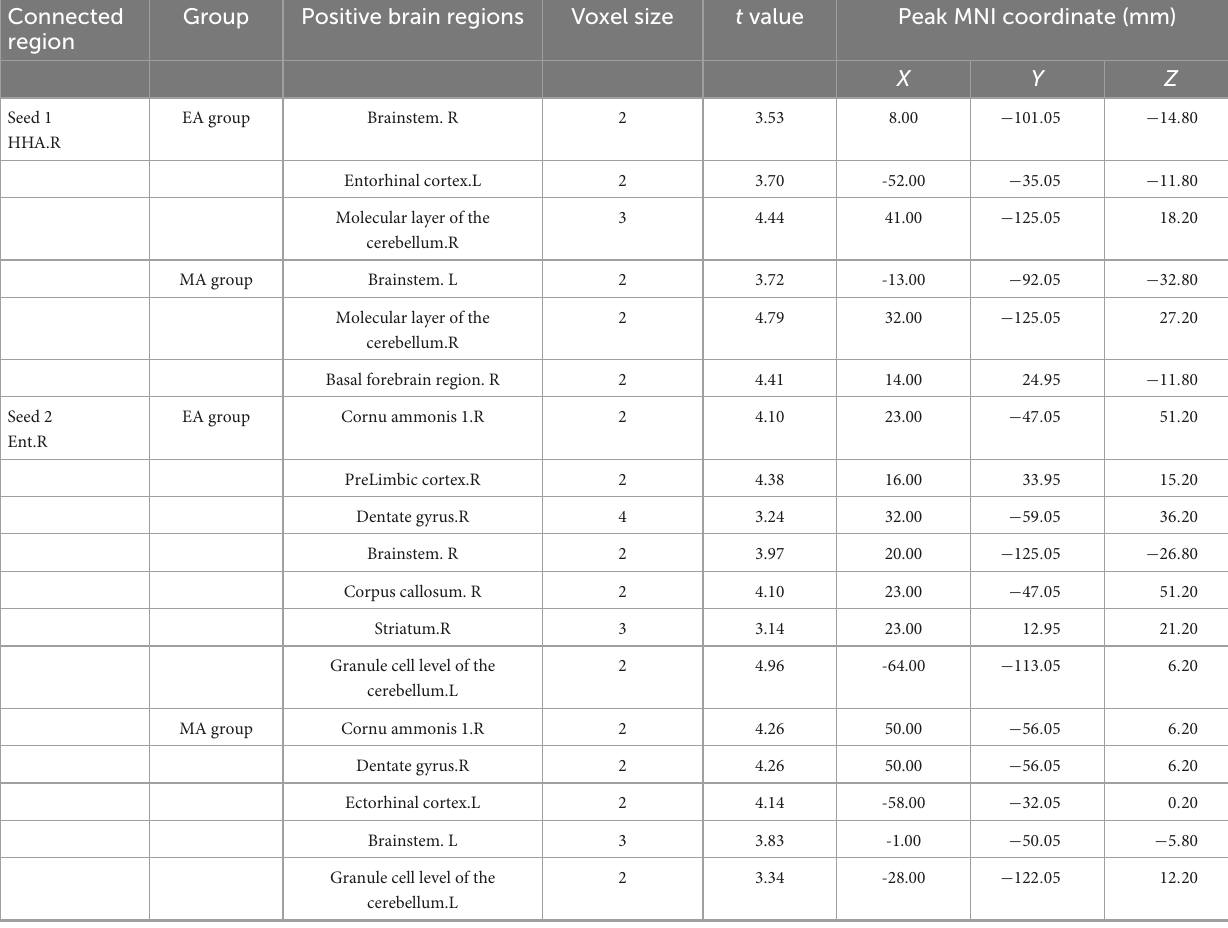
TABLE 1 The increased strengths of the functional connectivity (FC) in the electroacupuncture (EA), and the manual acupuncture (MA) groups in comparison with the spontaneously hypertensive rats (SHR) group.